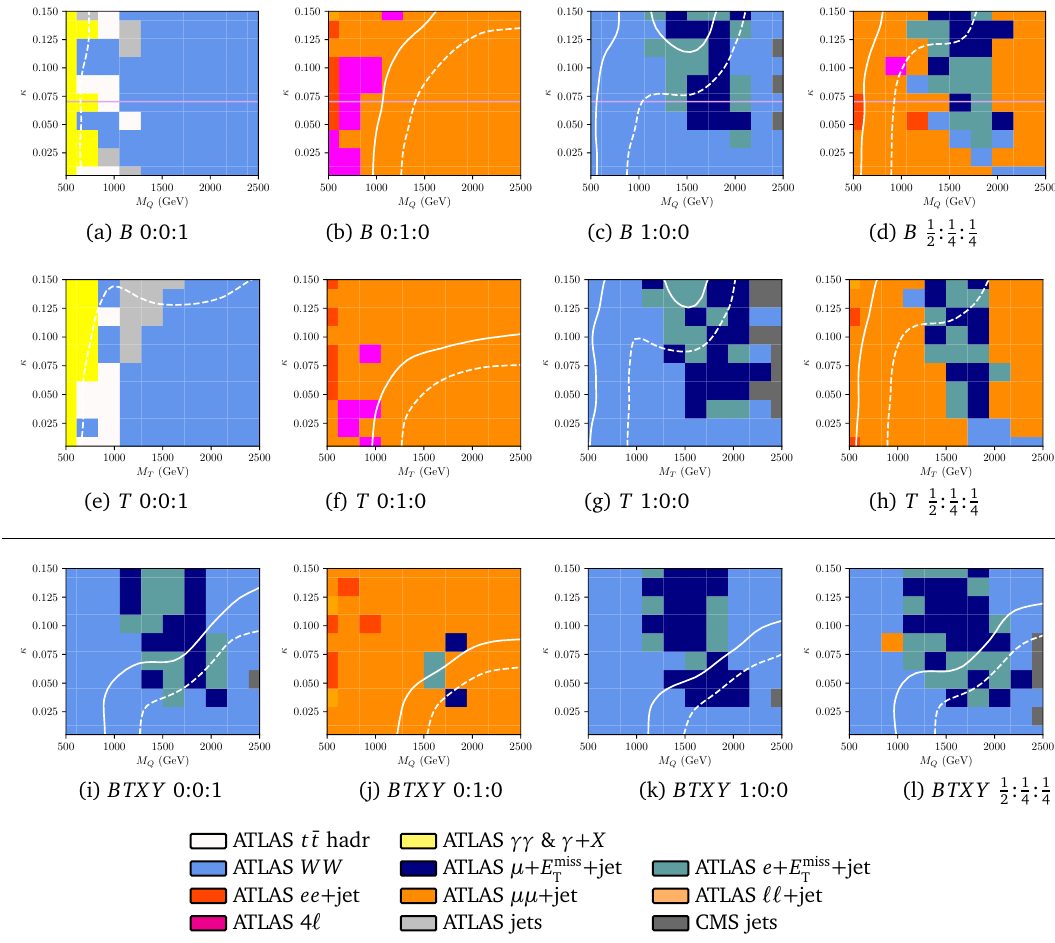
Figure 13: Sensitivity of LHC measurements to VLQ singlet production in the κ vs VLQ mass plane, where κ is the coupling to first-generation SM quarks. All VLQ masses are set to be degenerate. The multiplets are given as rows: (a)–(d) B singlet, (e)–(h) T singlet, and for comparison to the main text, the (i)–(l)( B , T , X , Y ) quadruplet. The VLQ branching fractions to W : Z : H are arranged in columns of 0:0:1, 0:1:0, 1:0:0, : 1 : 1 from left to and 1 2 4 4